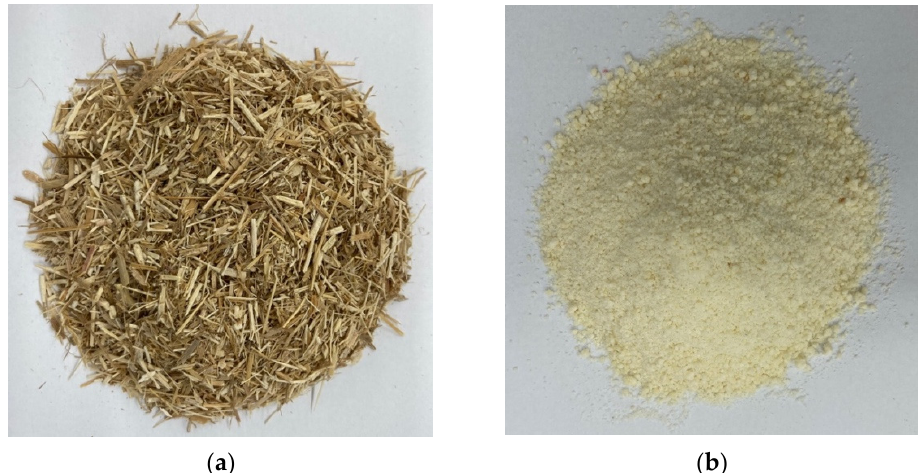
Figure 1. Experimental materials: ( a ) fragmented miscanthus biomass, ( b ) copra meal.